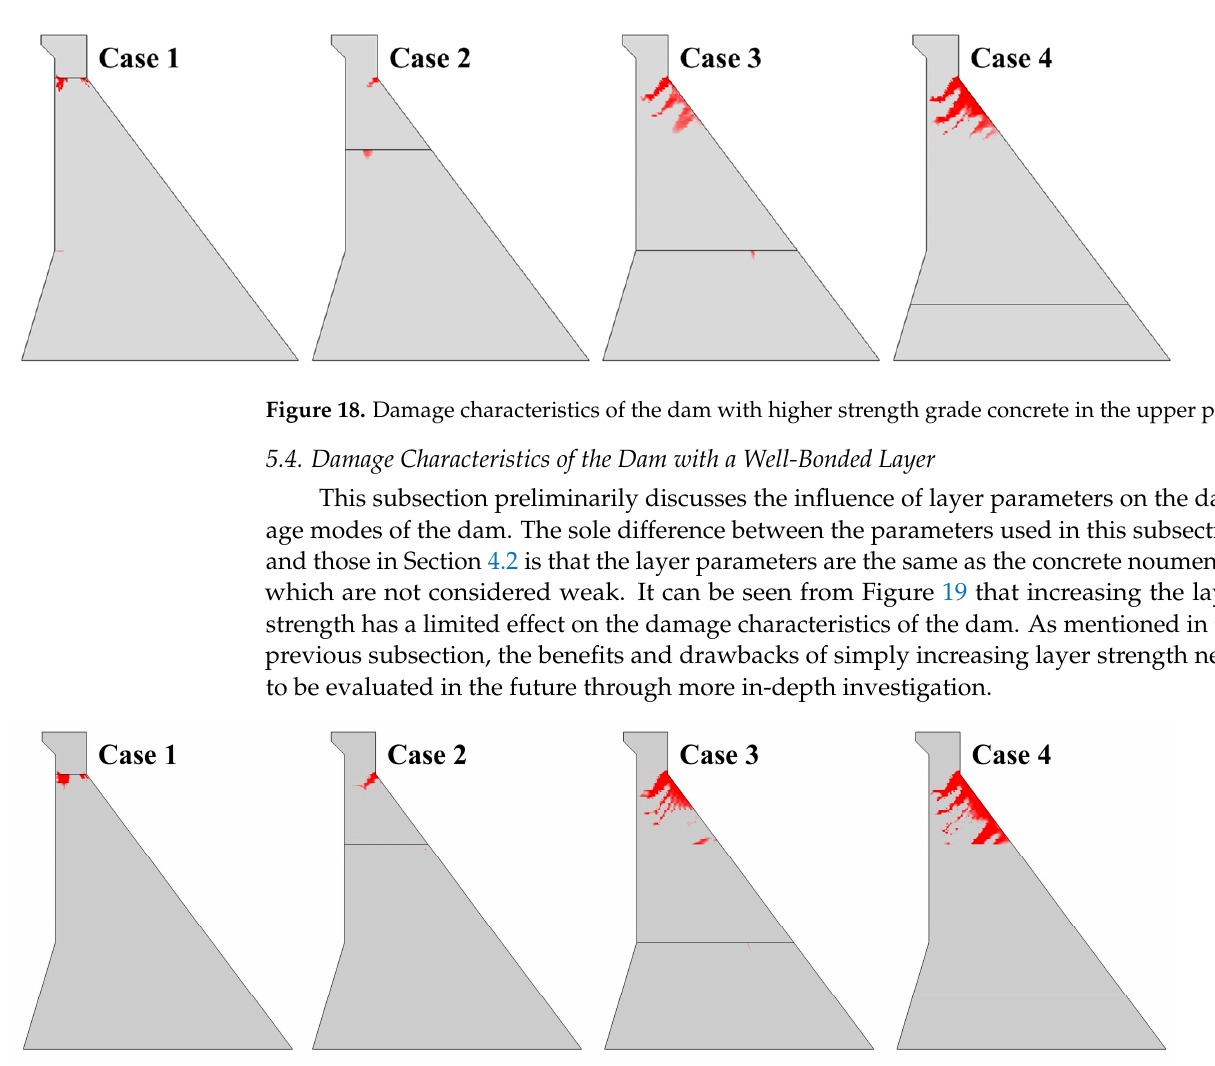
Figure 19. Damage characteristics of the dam with a well-bonded layer.